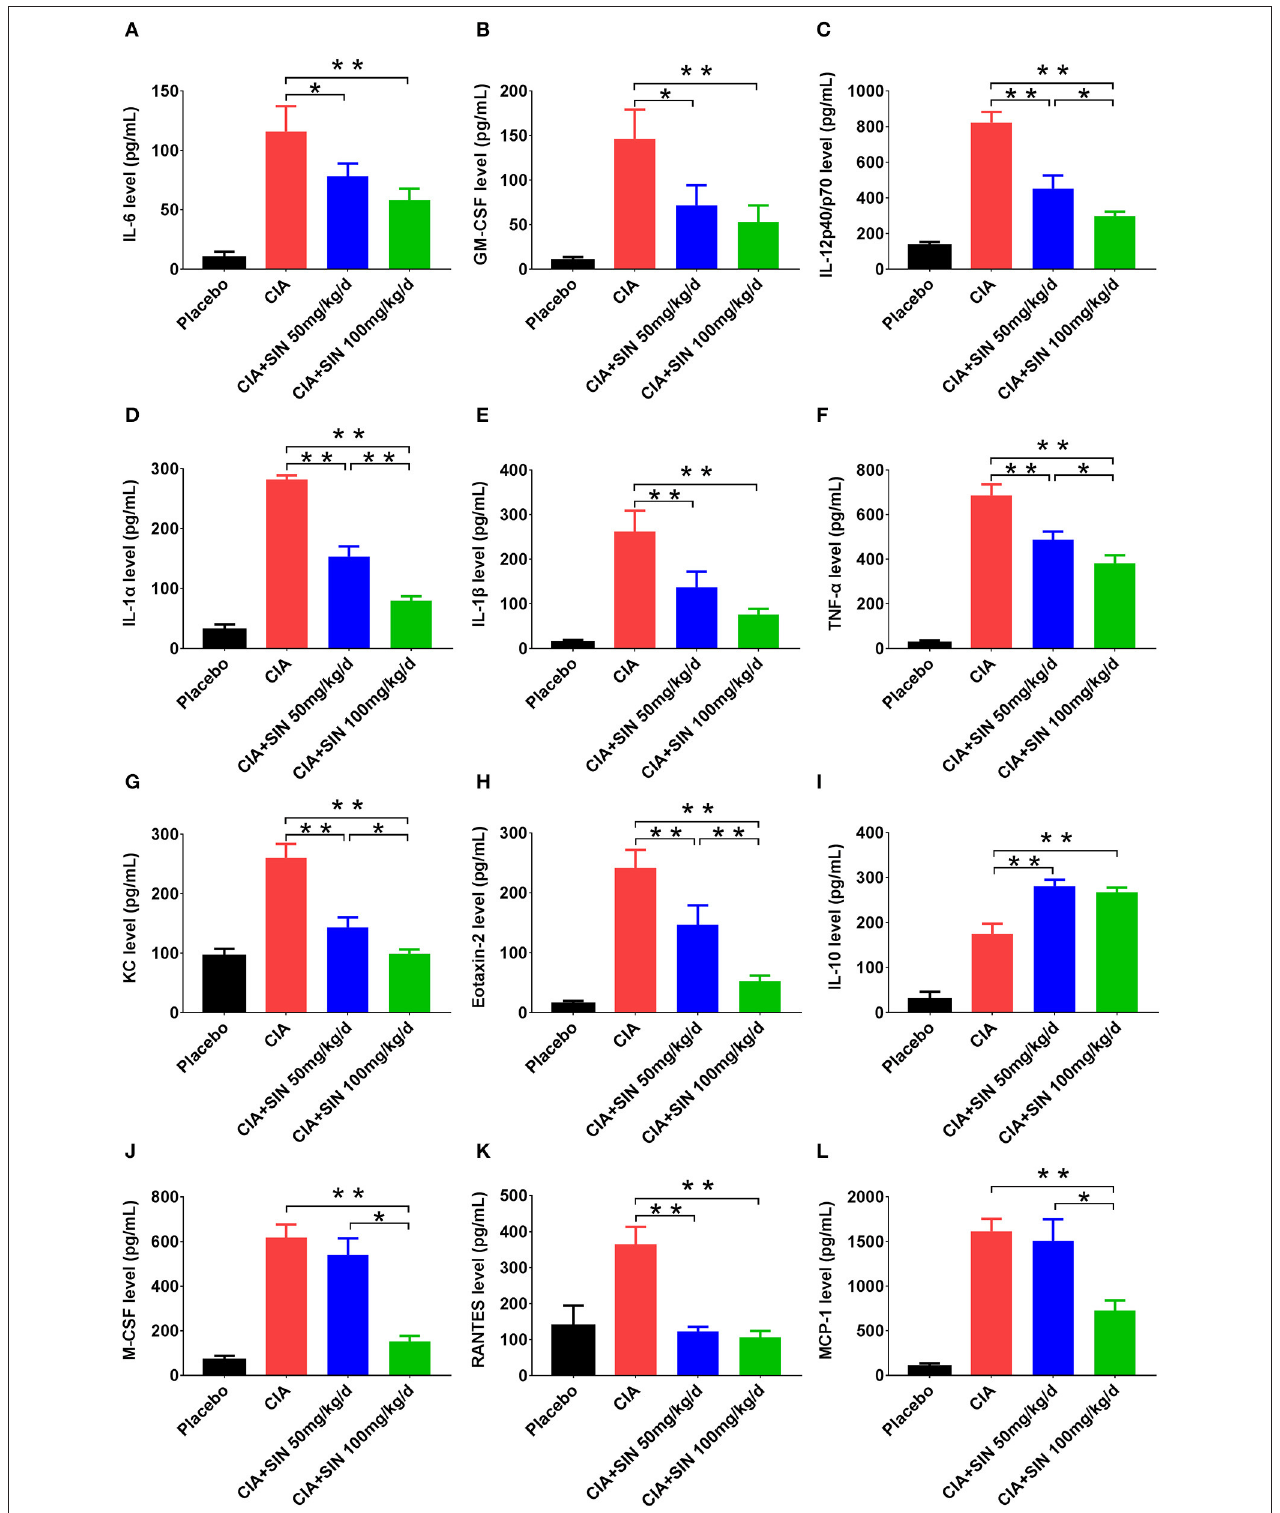
FIGURE 5 | Cytokines screened from LPS-induced RAW264.7 and SIN treatment in vitro were validated in vivo . Serum levels of (A) IL-6, (B) GM-CSF, (C) IL12-p40/p70, (D) IL-1 α , (E) IL-1 β , (F) TNF- α , (G) KC, (H) Eotaxin-2, (I) IL-10, (J) MCSF, (K) RANTES, (L) MCP-1 from mice in each group were measured by ELISA, respectively. Data are presented as the mean ± SD ( n = 6). Significance was analyzed by unpaired two-sided t -test (* P < 0.05, ** P < 0.01).